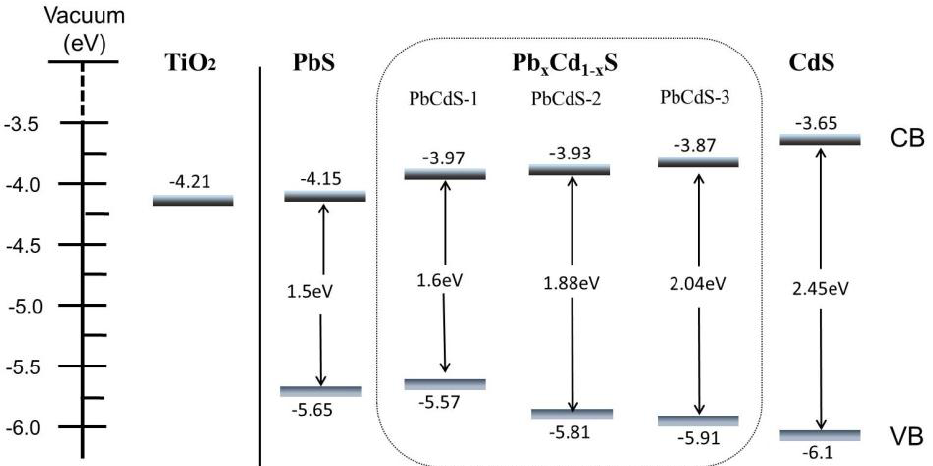
Scheme 1. Schematic diagram of edge energy levels of the conduction band (CB) edge and valence band (VB) edge for TiO 2 and five-SILAR-cycle PbS, CdS, and three kinds of Pb x Cd 1− x S.